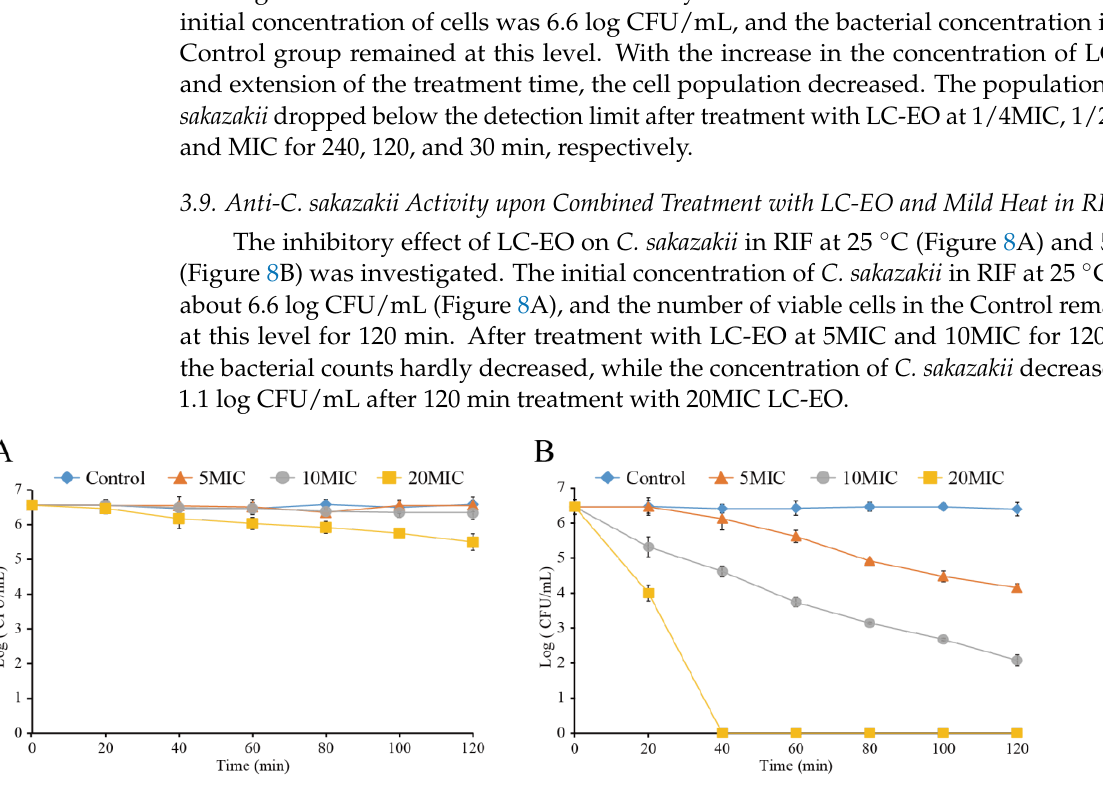
Figure 8. Effect of LC-EO on C. sakazakii populations in RIF at 25 °C ( A ) and 50 °C ( B ).